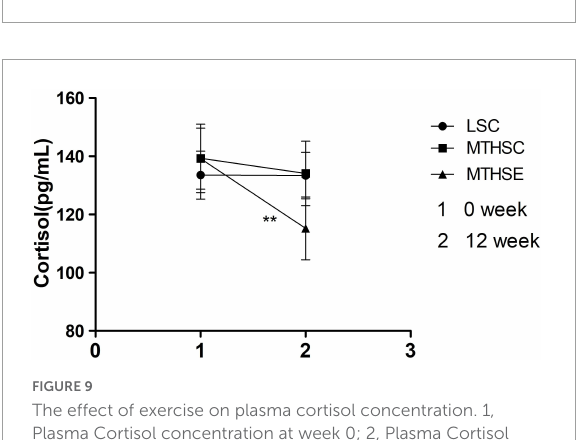
FIGURE9 The effect of exercise on plasma cortisol concentration. 1, Plasma Cortisol concentration at week 0; 2, Plasma Cortisol concentration at week 12; ** p < 0.01 , compared with Pre-intervention.